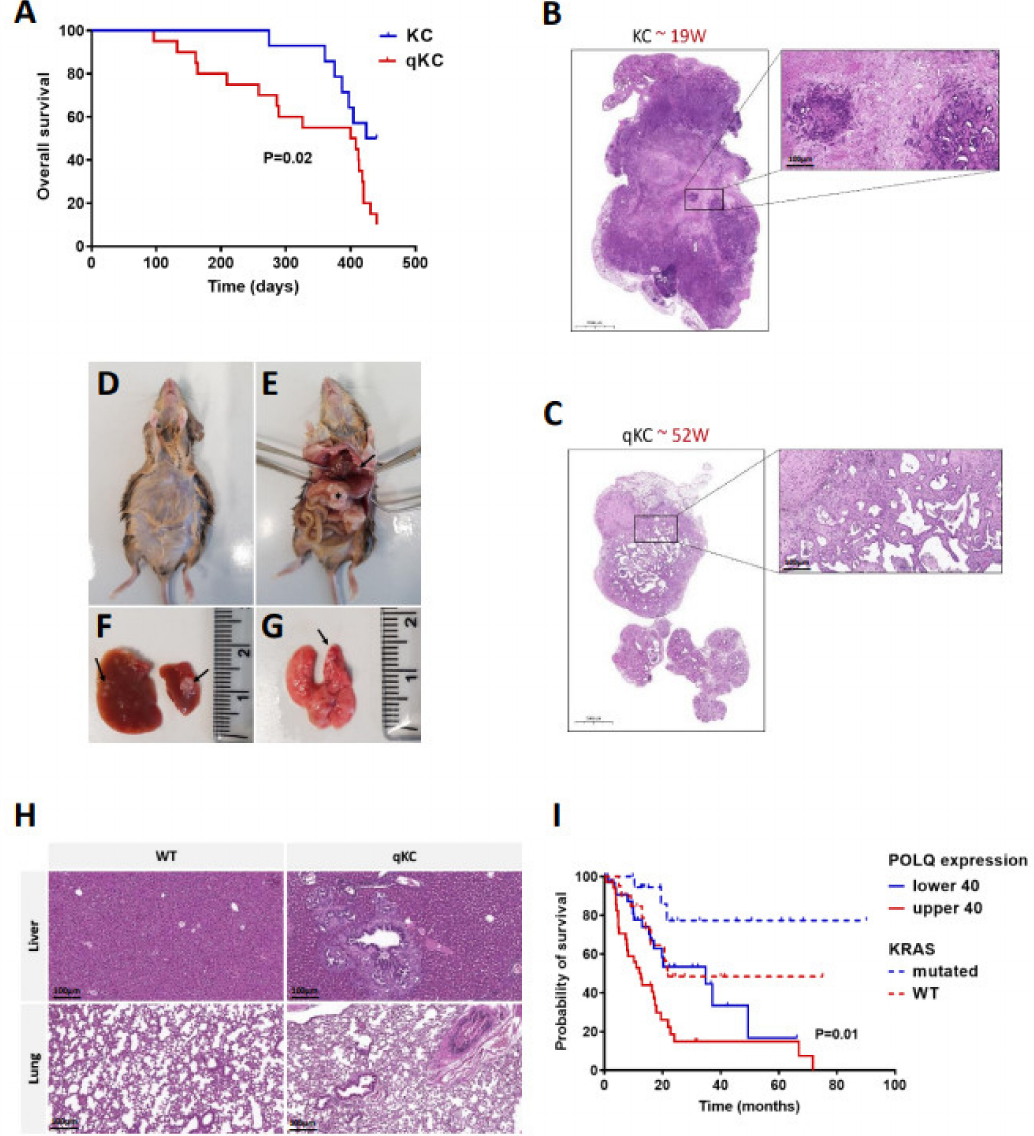
Figure 7. POLQ is significant for PDAC progression and overall survival. ( A ) Kaplan–Meier survival analysis for KC and qKC mice (KC mice, n = 20; qKC mice, n = 14; p = 0.02 by Mantel–Cox [log rank] test). ( B ) Representative images of pancreatic tumor from 19 week old KC mice (hematoxylin and eosin stain). ( C ) Representative images of pancreatic tumor from 52 week old qKC mice (hematoxylin and eosin stain; scale bars of enlarged images represent 100 µ m). ( D – H ) Pathological photographs of metastatic PDAC in a representative qKC mouse. ( D ) Abdominal distention is noted, due to the accumulation of malignant ascites. ( E ) Primary PDAC in the pancreas (asterisk) and liver metastasis (black arrow). Tissue sample from the same mouse showing ( F ) multiple liver metastases and ( G ) lung metastasis marked with black arrowheads. ( H ) Histology of healthy liver and lung of wild-type mouse, and liver and lung metastases of qKC mouse. Scale bars represent 100 µ m. ( I ) Kaplan–Meier survival analysis of TCGA PDA patients with low and high POLQ expression carrying KRAS wild- type or oncogenic KRAS (KRAS wild-type and lower POLQ expression, n = 20; KRAS wild-type and higher POLQ expression, n = 20; KRAS mutation and lower POLQ expression, n = 36; KRAS mutation and higher POLQ expression, n = 36; p value is indicated for comparison of patients with both KRAS mutation and higher or lower POLQ expression using the Mantel–Cox [log rank] test. Comparison of patient with both KRAS wild-type and higher or lower POLQ expression shows no statistical significance ( p >